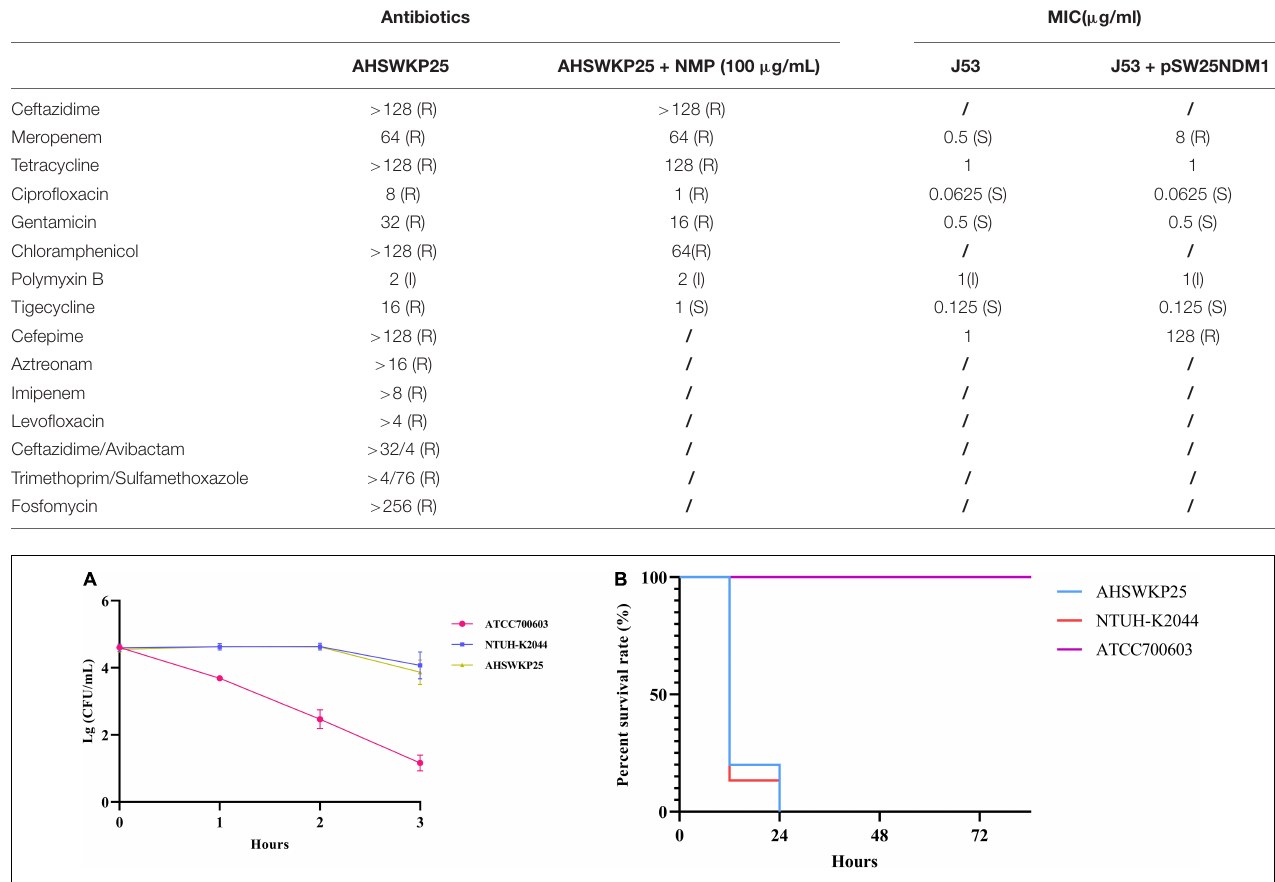
TABLE 1 | Antibiotic susceptibility tests of AHSWKP25 and its conjugants, and efflux pump phenotype test of AHSWKP25.